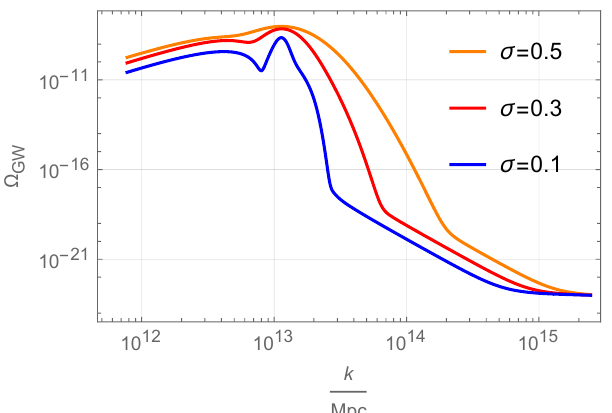
Figure 5. The induced GW spectrum for selected values σ < 1 of a sharp peak in the power spectrum, with the parameters P 0 = 6.57 × 10 − 13 , k peak = 10 13 Mpc − 1 and k final = 7.7 × 10 23 Mpc − 1